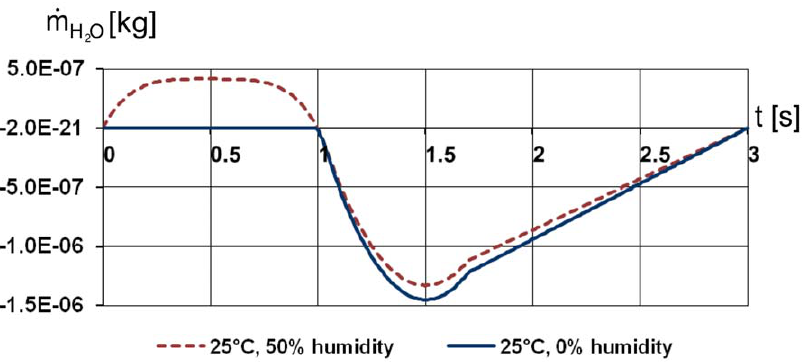
Figure 8. Flow rate of water vapour at tracheal orifice under two simulated experimental conditions. 1 s corresponds to end inspiration.